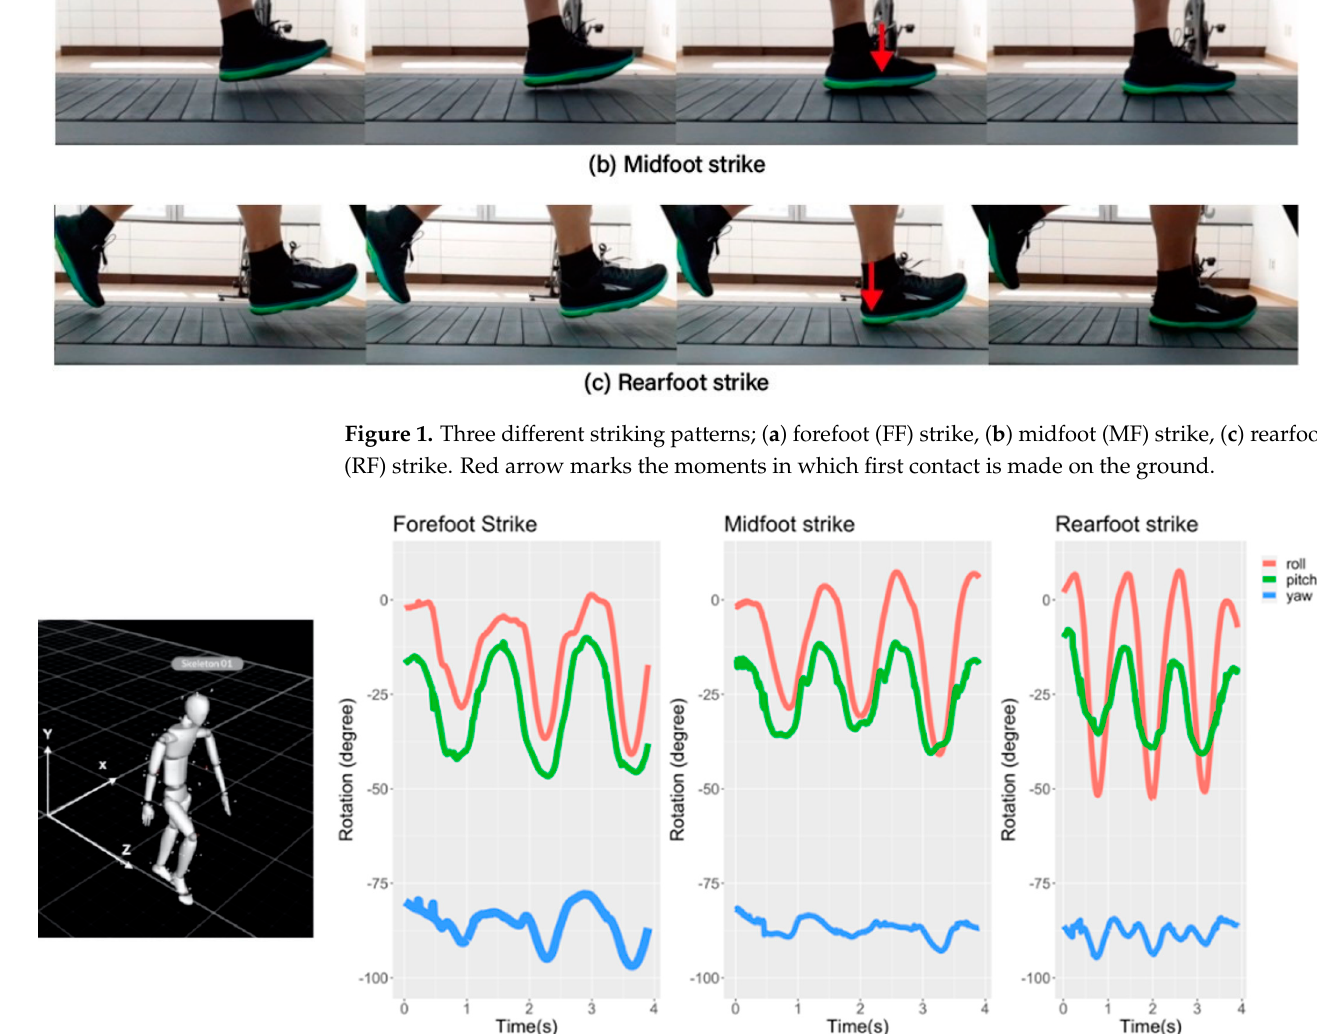
Figure 1. Three different striking patterns; ( a ) forefoot (FF) strike, ( b ) midfoot (MF) strike, ( c ) rear- foot (RF) strike. Red arrow marks the moments in which first contact is made on the ground.